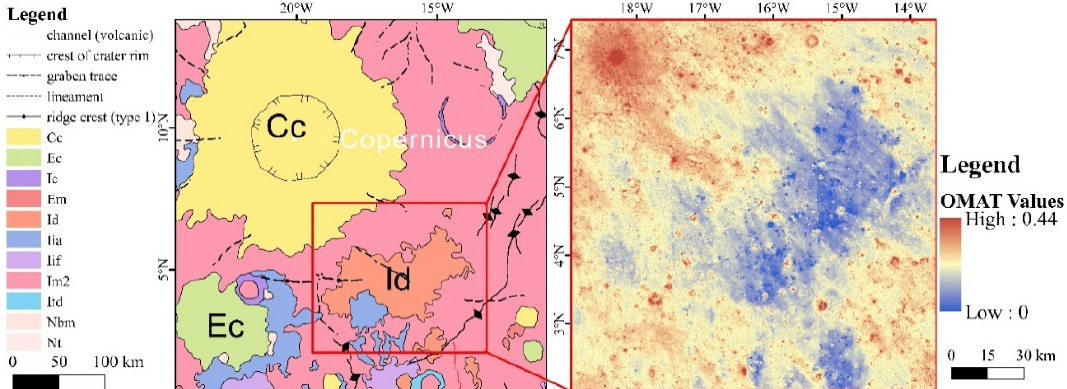
Figure 11. Position and the OMAT map of Sinus Aestuum-I DMD.